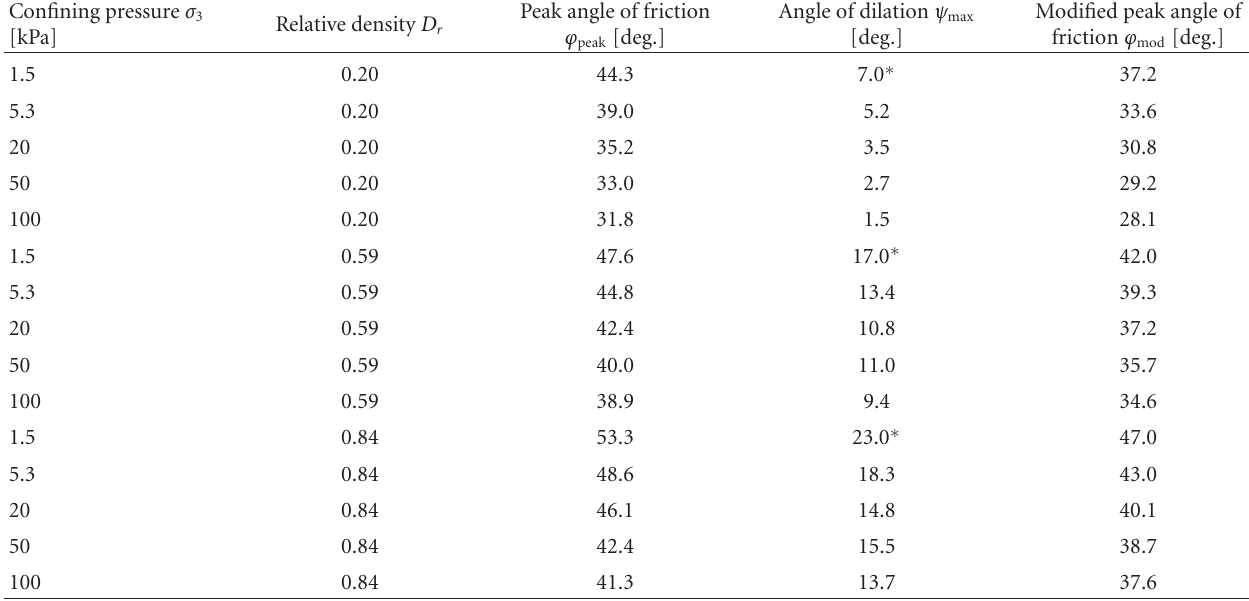
Table 2: Test results for Esbjerg sand, ∗ estimated value.